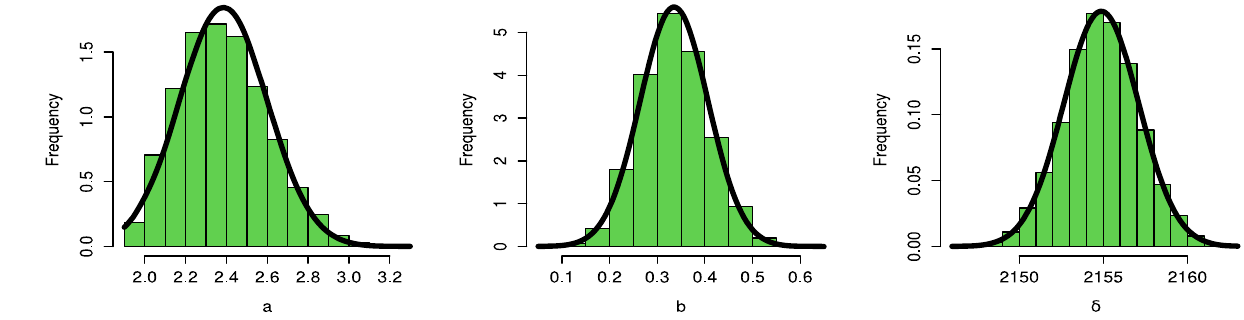
Figure 17. Histogram plots of MCMC results for the United Kingdom data set.